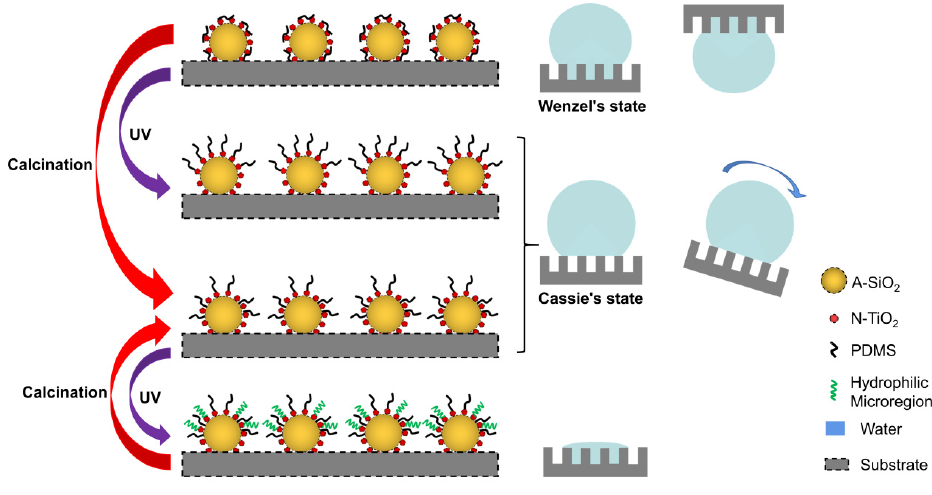
Figure 11. Wetting state and surface microstructure of the A-SiO 2 /N-TiO 2 @PDMS coating under different conditions.